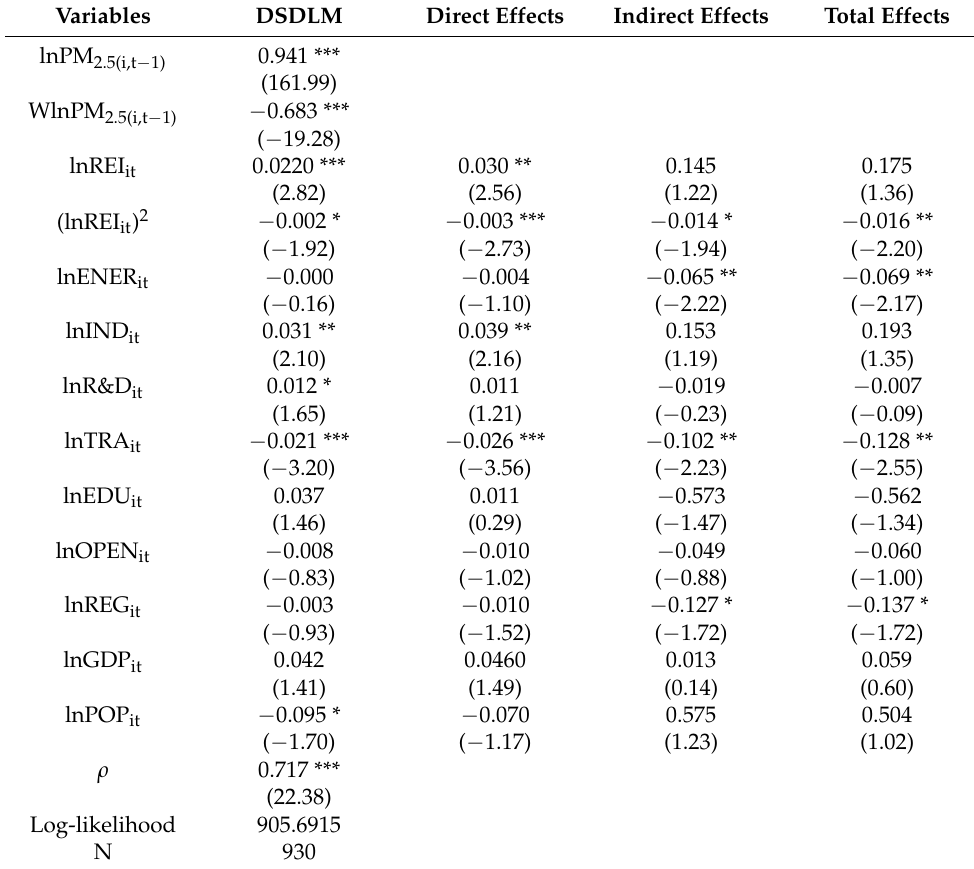
Table 5. Estimation results of the